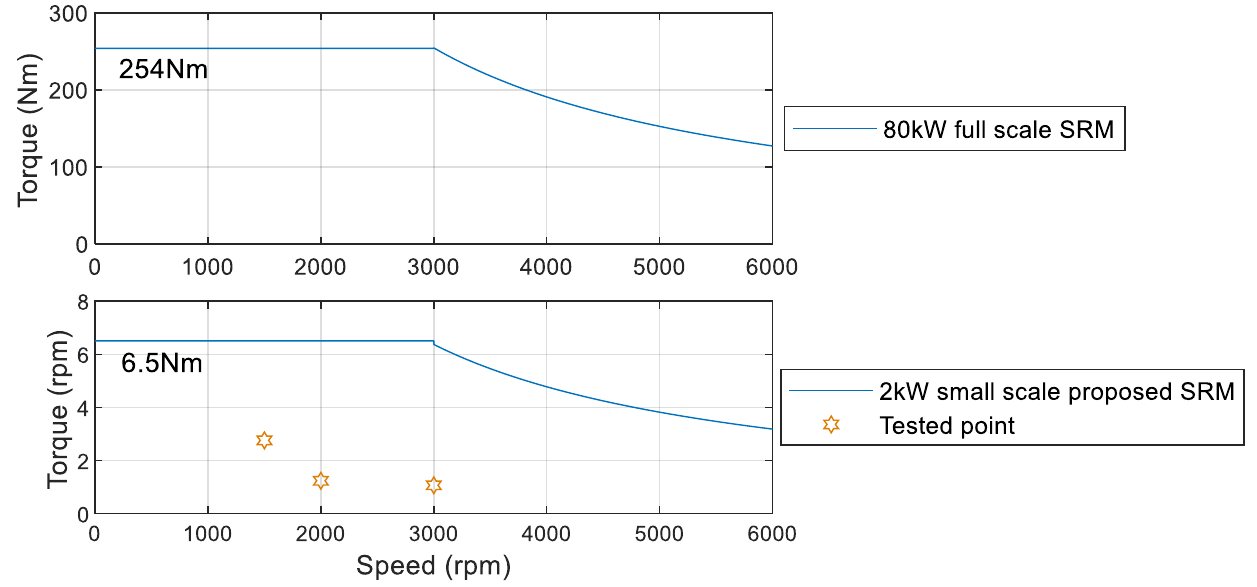
Figure 20. Torque speed specification for the full-scale SRM and the small-scale proposed SRM.